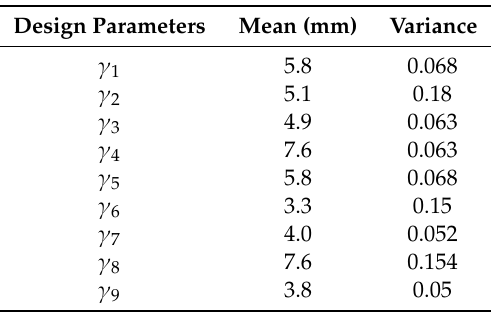
Table 1. Design parameters’ allowable